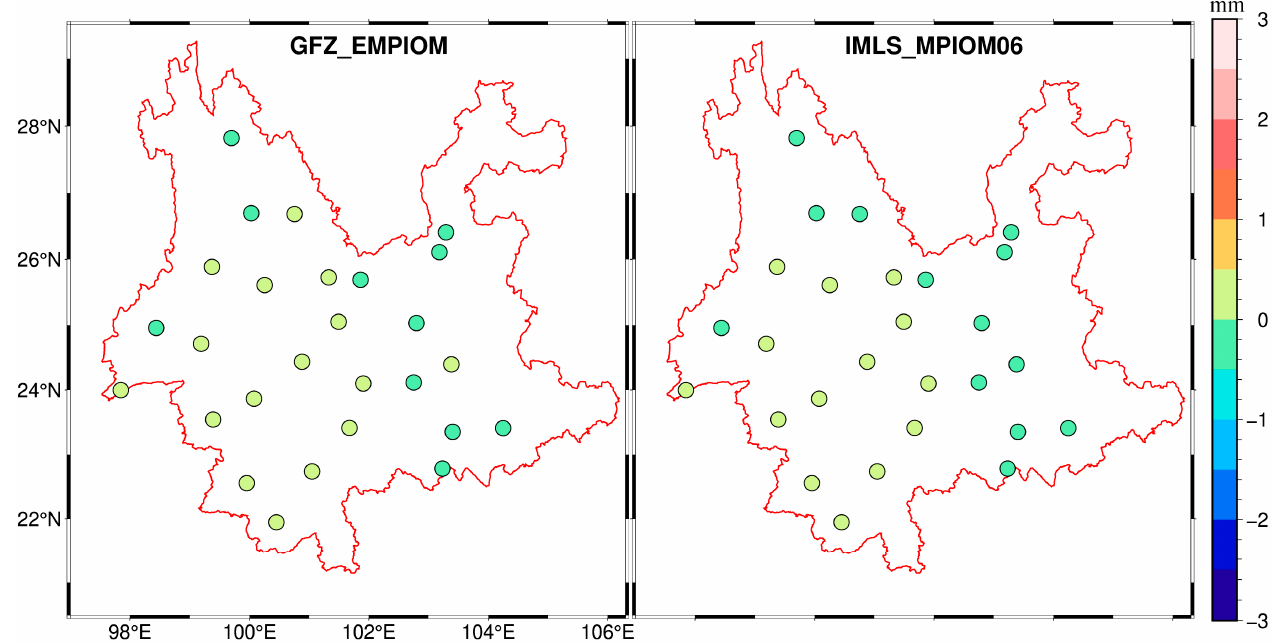
Figure 9. The RMS reductions at 27 GPS stations after two NTOL products correction.